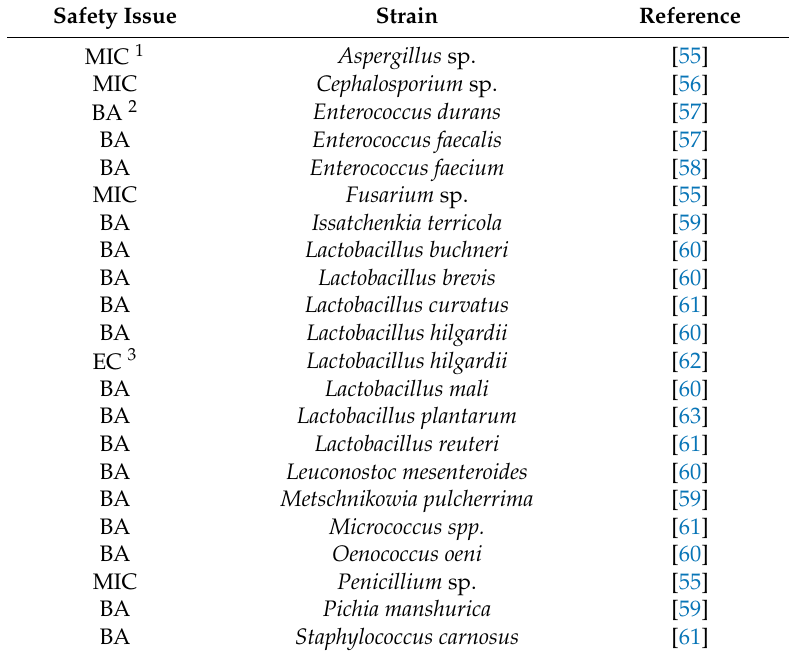
Table 4. Presence of at least one strain belonging to the genera/species reported in Table 1 (thus associated with fermented matrices) and for which has been reported in literature a concern of safety